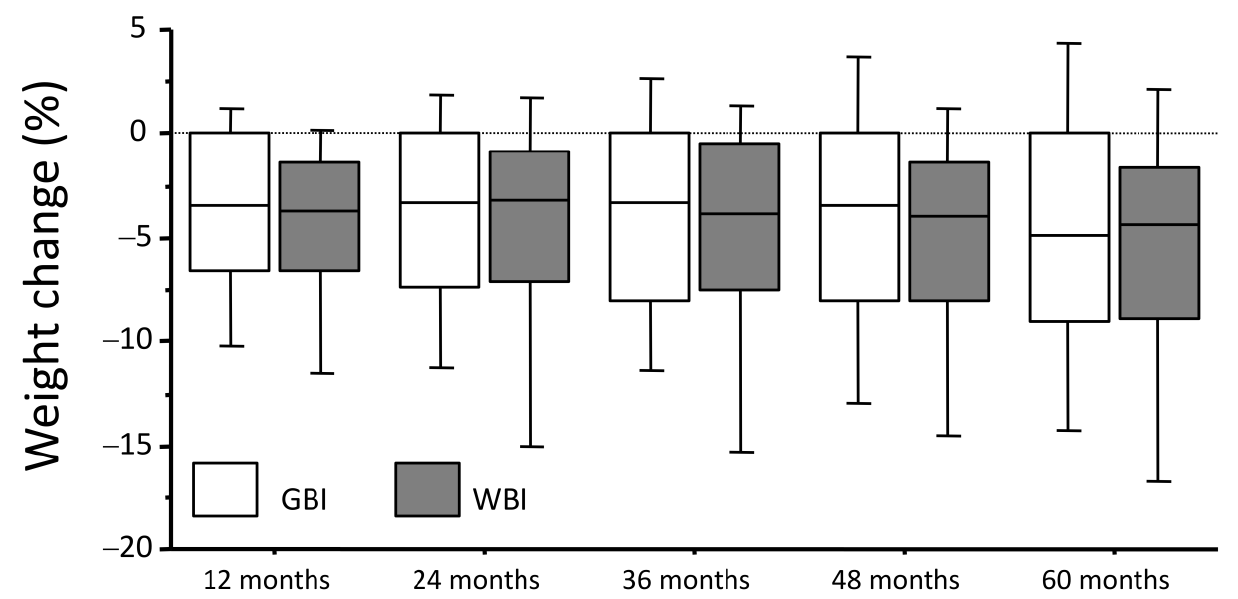
Figure 1. Percent weight change in the course of the follow-up according to group-based (GBI) and web-based (WBI) intervention programs. Legend: In this box and whiskers plot, the horizontal lines correspond to medians, the boxes cover the 25° – 75° percentile area and the whiskers extend to 5° – 95° of variance. No difference between paired boxes were observed at any time point.